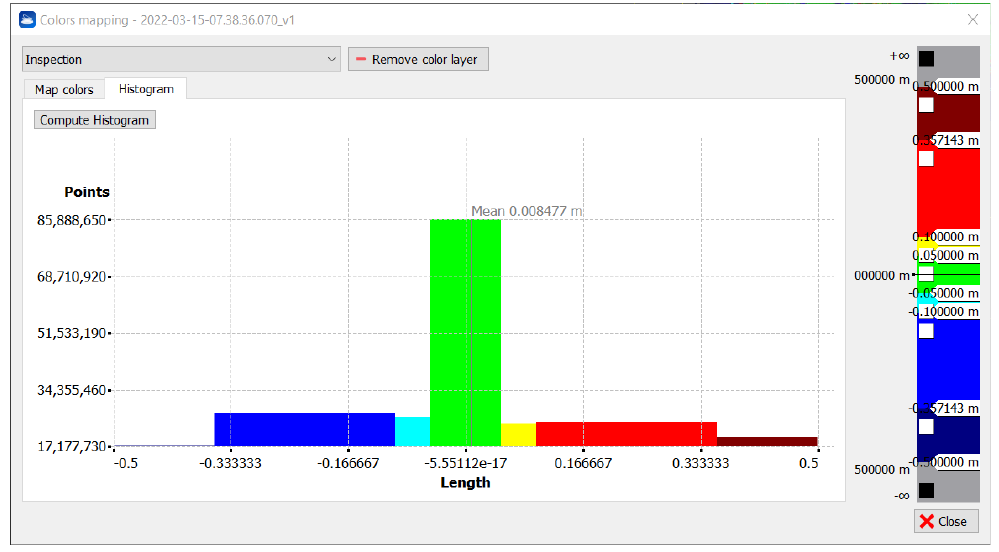
Figure 7. Inspection tool configured to compare BIM model based mesh and point cloud with voxelization of 1 cm. accuracy is also improved with more meticulous voxeling parameters.